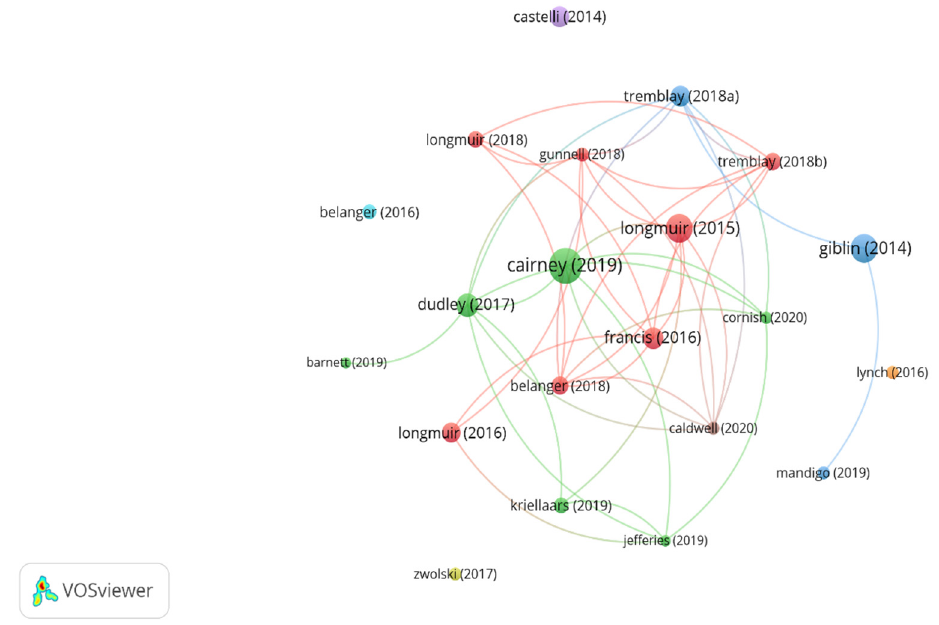
Figure 3. Most-cited articles.